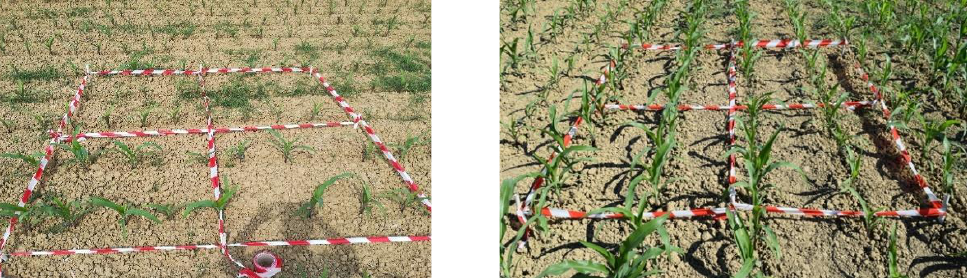
Figure 1. Experimental plots (control plot to the ( left ) and pulling weed plots, to the ( right )). At the 4 – 5 leaf stage, the number of plants of maize (NM) and weeds (NW) was counted on each plot. Afterwards, half of the plots were weeded (weeded plots = WP) by using 0.5 l ha −1 of Aric 480 L.S. (41% Dicamba) and 1.5 l ha −1 of Nifuron (4.18% Nicosolfu- ron), whereas no intervention was carried out on the remaining four plots (control plots = CP). At harvest time, the aboveground biomass of all maize plants was collected from each plot (WP and CP) and weighed after oven drying at 60 °C until constant weight. On the other four plots of 4 m 2 (2.0 m × 2.0 m), the number of maize plants was counted and all weeds were removed manually before the UAV flight (pulling weed plots = PWP) in order to estimate more easily the average cover value of a single maize plant. The UAV flight was made on the 25th of June over the entire surface of both fields, just before the weed and crop scouting. We used the drone “Agri - Efesto”, made available by Sigma Ingegneria and the Precision Agriculture group of the CNR-IBIMET of Florence. The drone was a modified multi-rotor Mikrokopter (HiSystems GmbH, Moomerland, Germany) with six MK3538 and APC propellers 12 × 3.8 inches. Autonomous fight through a predefined route was set using the onboard navigation system based on a GPS receiver (U-blox LEA6S) connected to a navigation board (Navy-Ctrl 2.0) and a small Mi- croelectromechanical System (MEMS)-based IMU (Inertial Measurement Unit) (Mikro- kopter Flight Controller ME V2.1). A universal camera mount equipped with three servo- motors permitted accurate image acquisition through the compensation for tilt and rolling effects. The Agri-Efesto was equipped with a Sony Cyber-shot DSC-QX100 RGB camera (Sony Corporation, Tokyo, Japan), which mounts a 20.2-megapixel CMOS Exmor R sensor and a Carl Zeiss Vario-Sonnar T lens. The UAV flight was made at 10 and 20 m in height, with a ground-size pixel equal to 3.5 mm and 7.1 mm, respectively, maintaining an overlap of 70% between the individual frames. 2.3. Image Processing The RGB images of experimental plots acquired from the UAV were orthorectified and mosaicked using Agisoft Photoscan Professional Edition 1.1.6 (Agisoft LLC, St. Pe- tersburg, Russia). The orthomosaic was processed with Canopeo, which analyses images by using col- our values in the red (R), green (G) and blue (B) system and classifies all pixels according to three selection parameters: R/G, B/G and the green excess index (GEI = 2G-R-B) [36 – 39]. The starting image was turned into a binary image depending on whether the pixels met the selection criteria or not (R/G < 0.95, B/G < 0.95, and GEI > 20, default values). In this way, we obtained the total green cover for the WP and CP (Ca-TGC WP+CP ). In order to estimate the values of MGC and WGC for the WP and CP, we tested two different methods. In the first method (M1), we expressed the Ca-TGC WP+CP as the sum of MGC WP+CP and WGC WP+CP (1) and they, in turn, are expressed as the product of the number of maize/weed plants by the average cover of a single plant of maize/weed (2) and (3) (Figure 2).